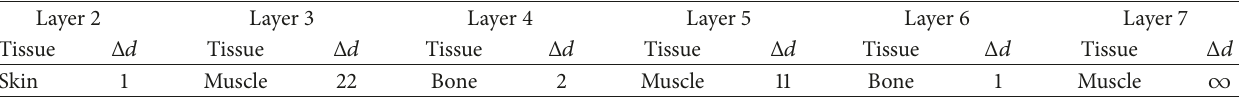
Table 1: Tissue composition used for the neurostimulator. The receiver is placed at 3.4 cm below the air-tissue interface (layer 5). The unit for the thickness ( Δ𝑑 ) is